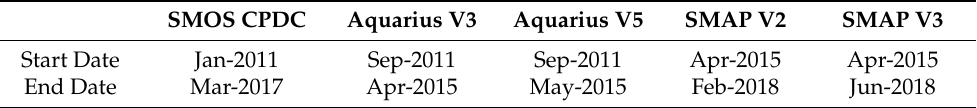
Figure 11. Histogram of SSS from (red) Argo in situ measurements and satellite SSS measurements by ( a ) SMOS and Aquarius, and ( b ) SMAP. They are computed from global monthly maps at 1 ◦ × 1 ◦ resolution in latitude and longitude over the period ( a ) Sept 2011–May 2015 and ( b ) April 2015–June 2018. The x-axis sampling is 0.05 psu; the x-axis is cropped between 30 and 40 psu. Table 4. Start and end date for the statistics of the differences between satellite products and Argo in situ